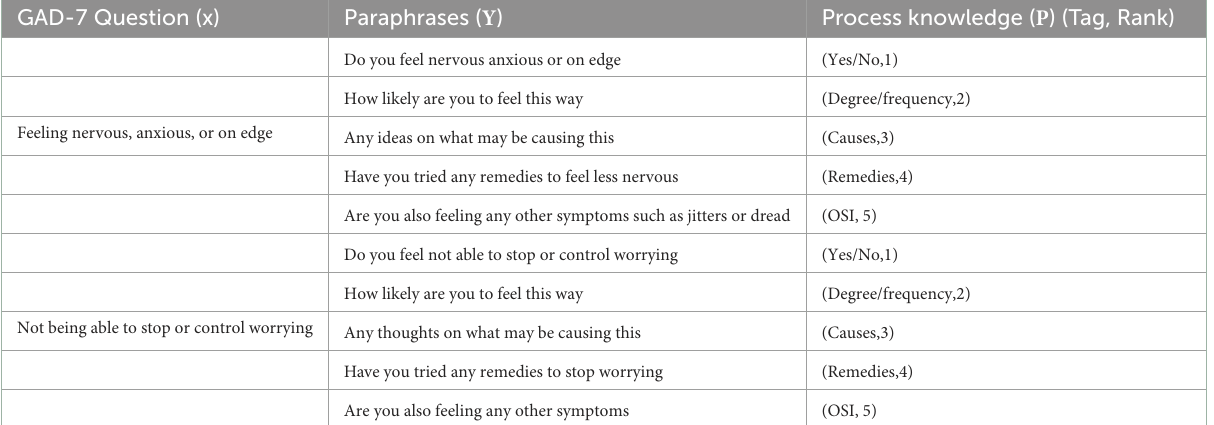
TABLE 2 Examples of ProKnow -data for GAD-7. GAD-7 Question